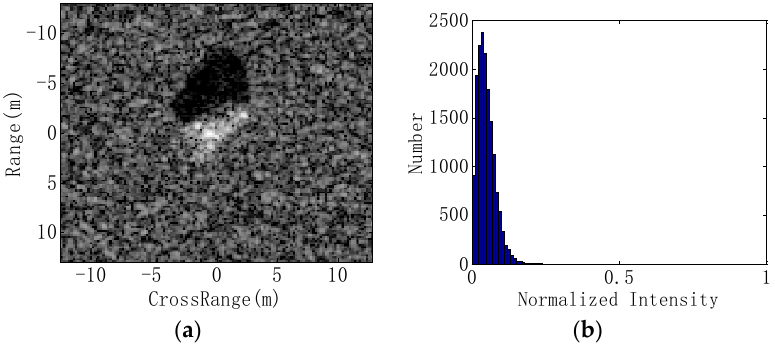
Figure 2. Histogram of an SAR image: ( a ) Original image; ( b ) Histogram.